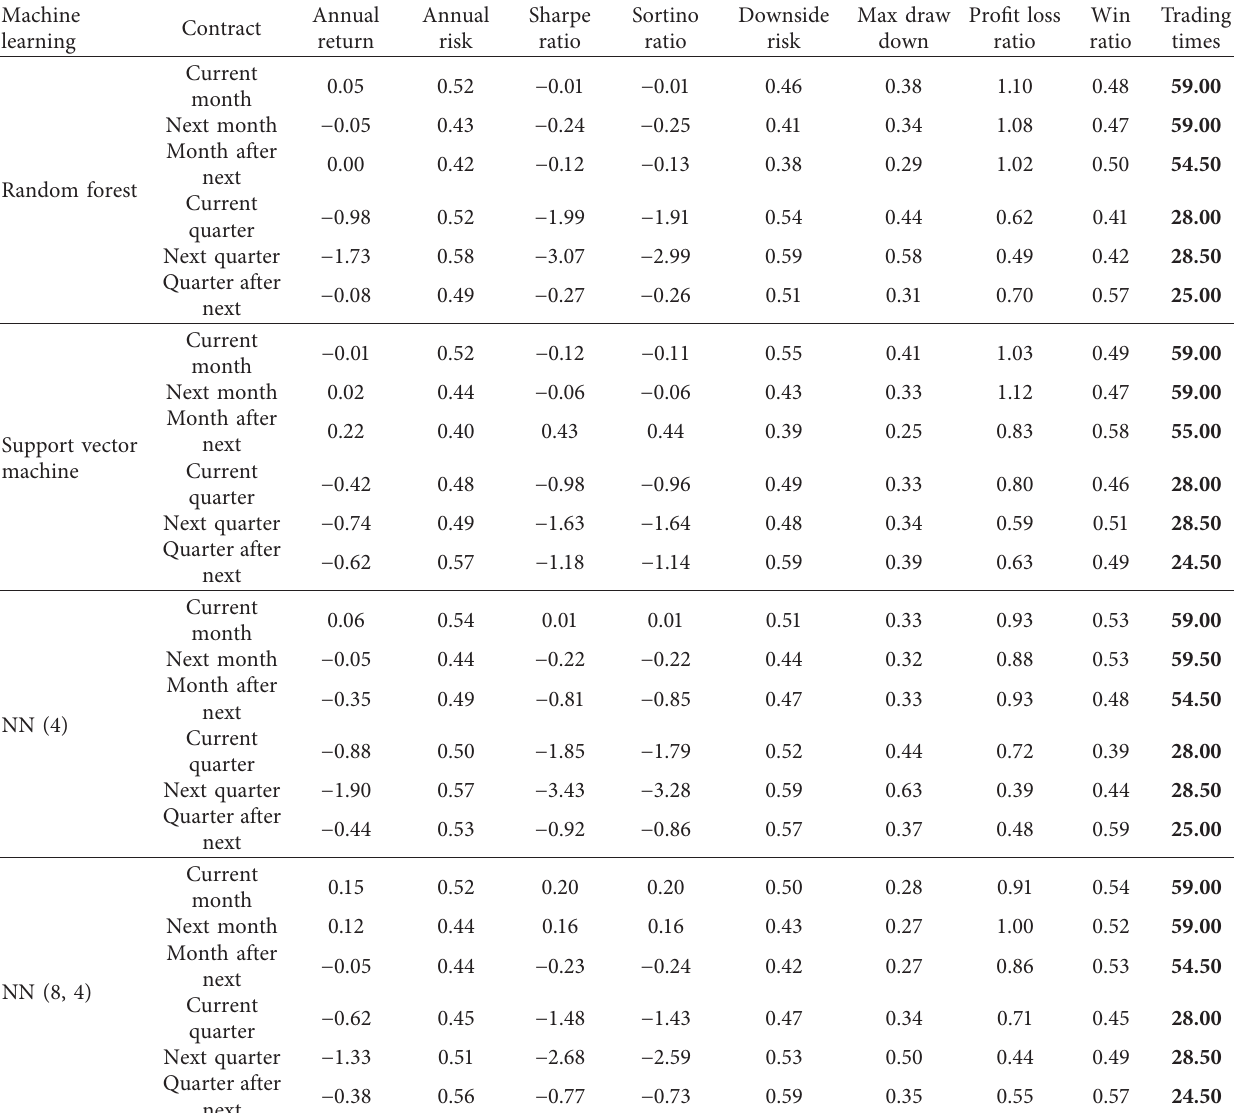
Table 6: Option strategy for directly predicting the rise and fall of volatility (use 30 features M4).